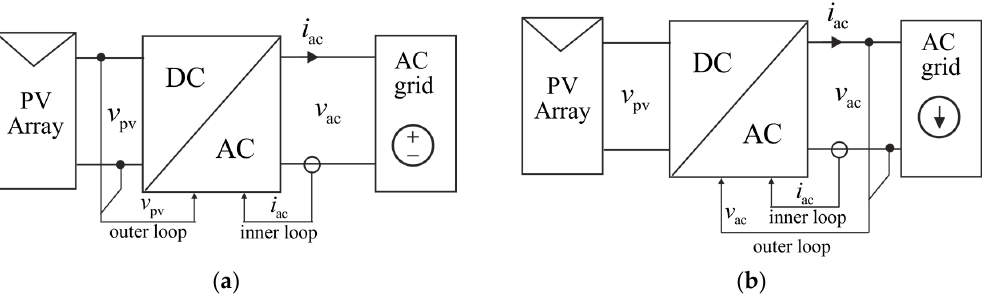
Figure 15. Operation modes of single-stage grid-connected PV energy system: ( a ) grid-feeding/supporting mode; and ( b ) grid-forming mode.